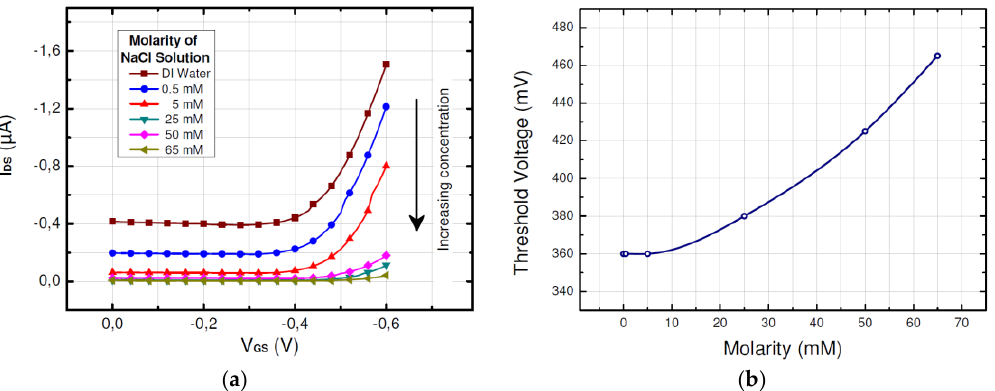
Figure 5. I DS vs. V GS graphs of WG-FET for various NaCl molarities of the solution droplet ( a ); Threshold voltage of WG-FET vs. molarity of the NaCl solution ( b